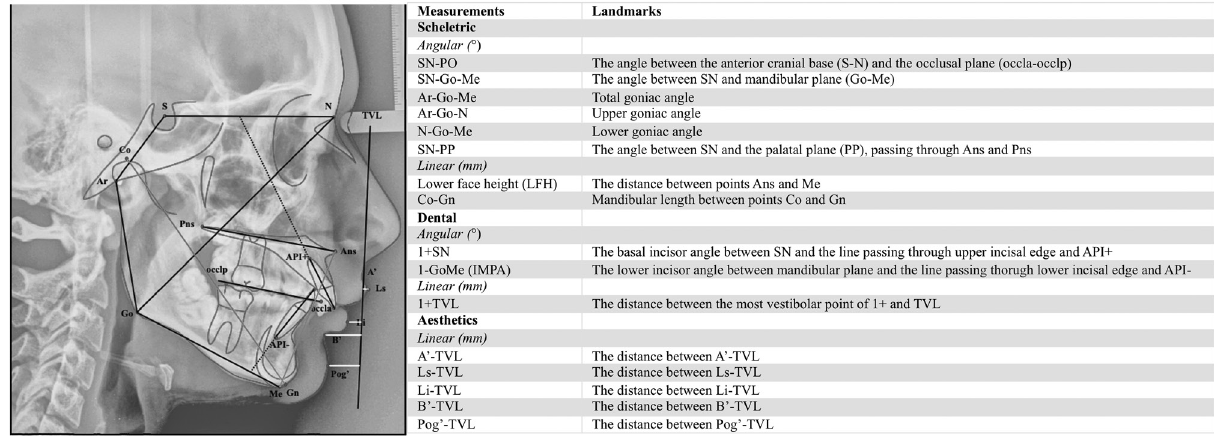
Figure 4. Reference lines for cephalometric